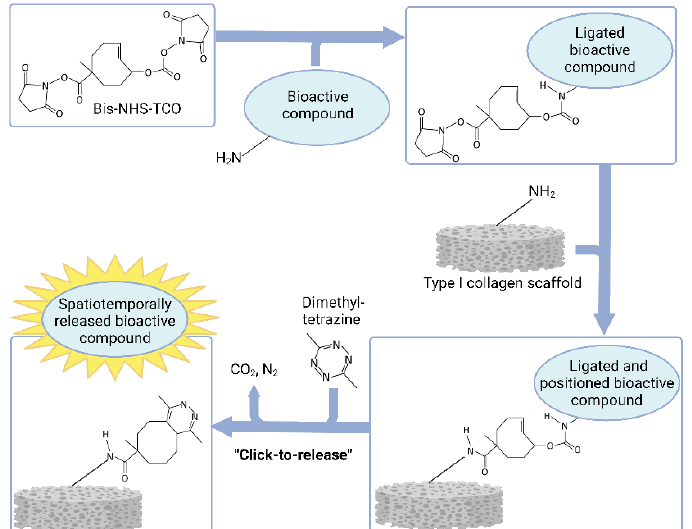
Figure 1. Schematic representation of the functionalization of the bis-N-hydroxysuccinimide (NHS)- functionalized TCO molecule (bis-NHS-TCO) with an amine-containing bioactive compound, followed by conjugation to a collagen scaffold and subsequent spatiotemporal release of the bioactive compound after “clicking” the bis-NHS-TCO with dimethyl-tetrazine. Created with BioRender.com.